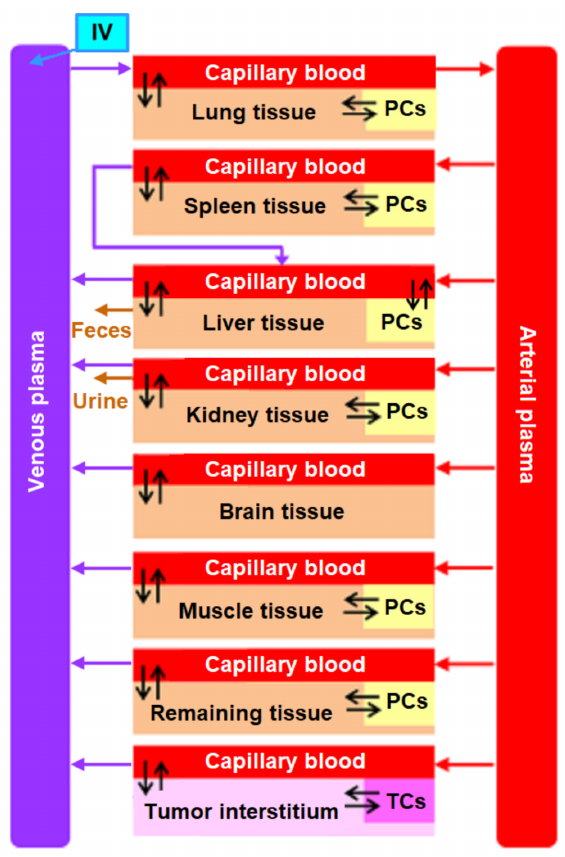
Figure 1. Schematic diagram of the physiologically based pharmacokinetic (PBPK) model of nanopar- ticle delivery to solid tumors in mice as presented by Cheng et al. Intravenously administered (IV) nanoparticles enter the arterial blood through the lungs, and then move to other organs and tissues of mice. Except plasma and the brain, each compartment of the model is divided into three major parts: capillary blood, tissue interstitium, and endocytic/phagocytic cells (PCs) or tumor cells (TCs). (Used with permission from https://pubs.acs.org/doi/10.1021/acsnano.9b08142 accessed on 1 April 2022. Copyright (2020) American Chemical Society. Further permissions related to the material excerpted should be directed to the American Chemical